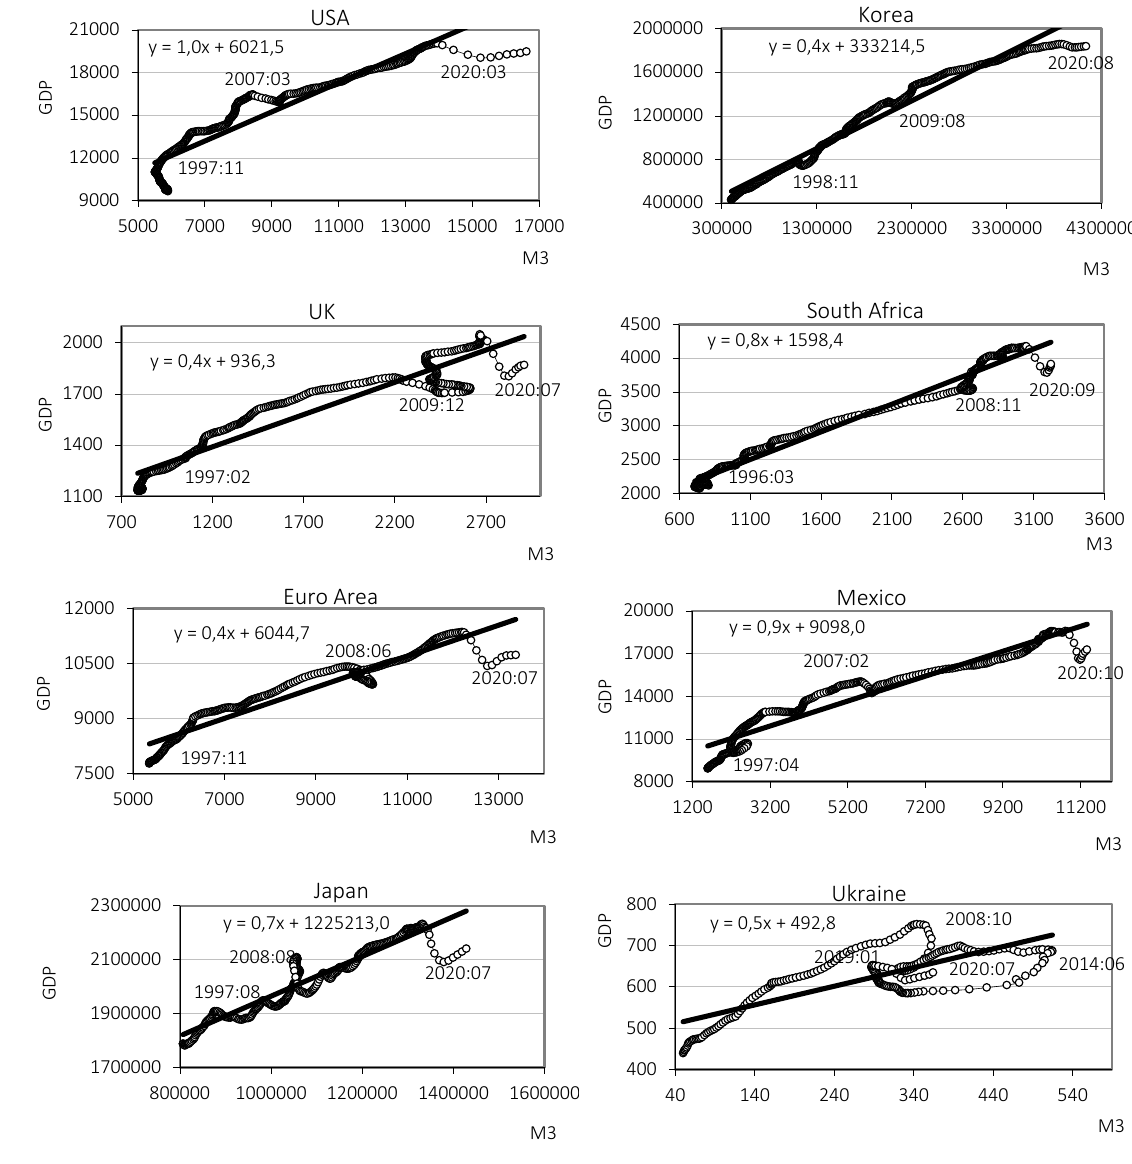
Figure 2. Correlation between money supply and output in real terms for several